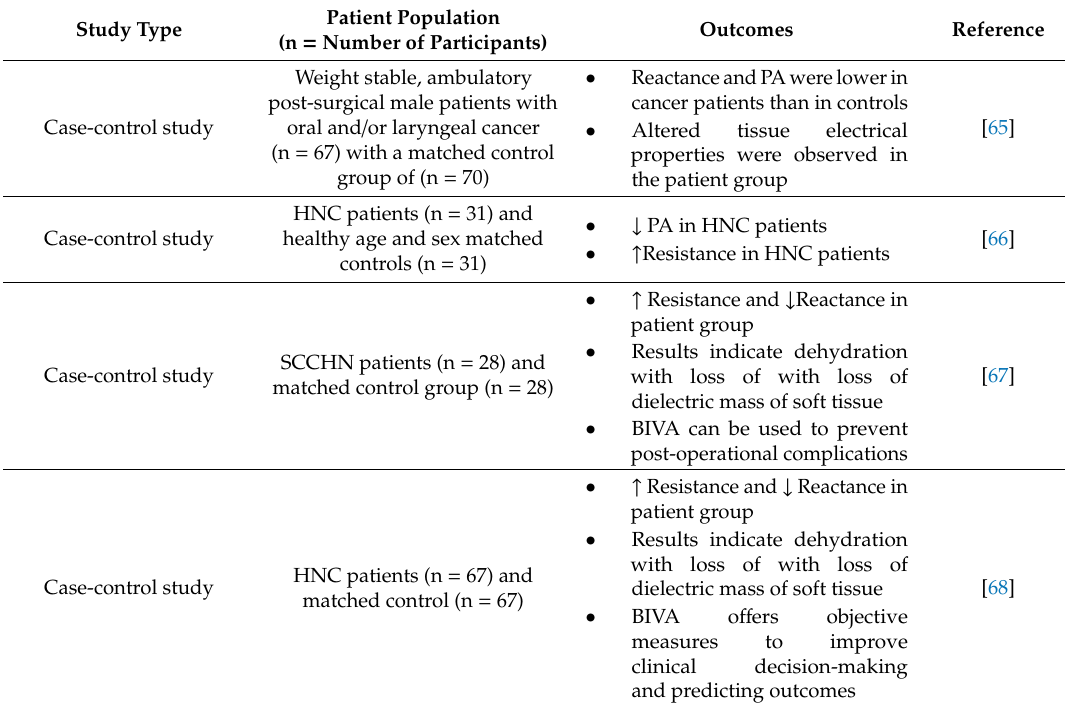
Table 4. Studies examining changes in the tissue electrical properties of head and neck cancer